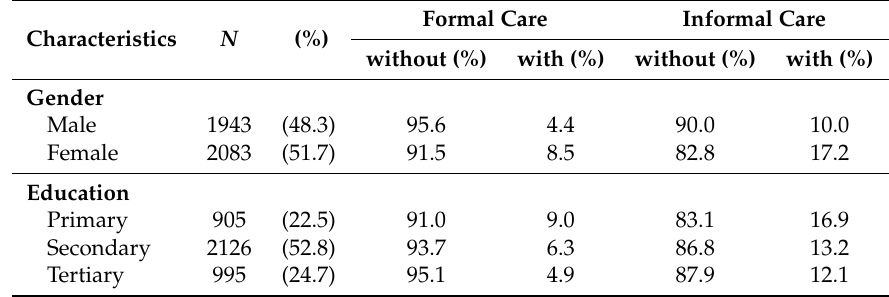
Table 3. Descriptive statistics of the exogenous characteristics affecting long-term care (LTC)